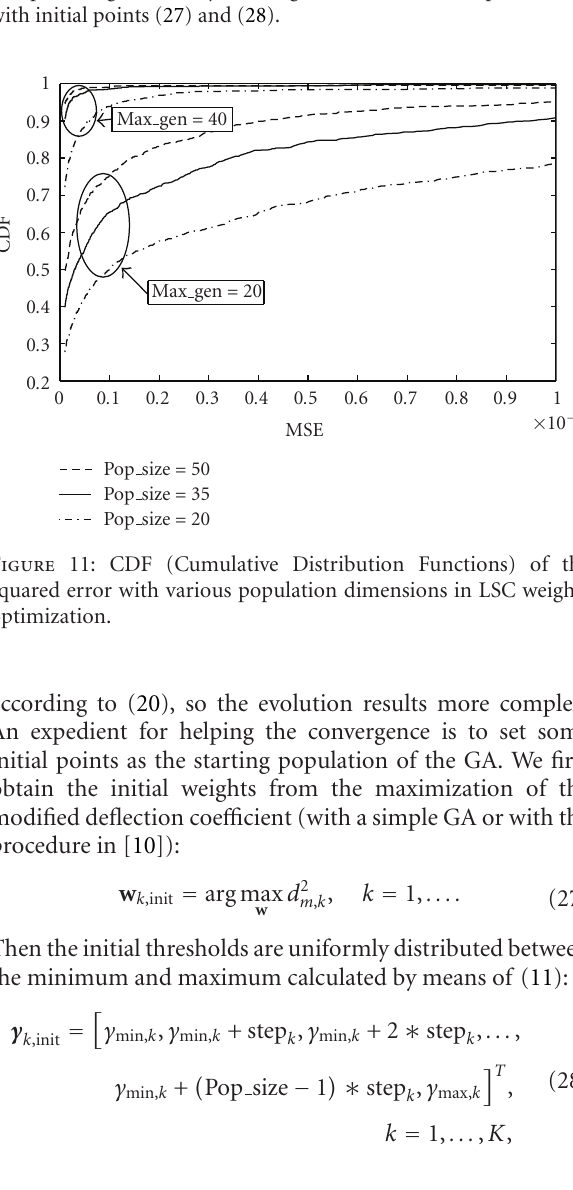
Figure 10: CDF (Cumulative Distribution Function) of the abso- lute percentage error in joint weights and thresholds optimization with initial points (27) and (28).